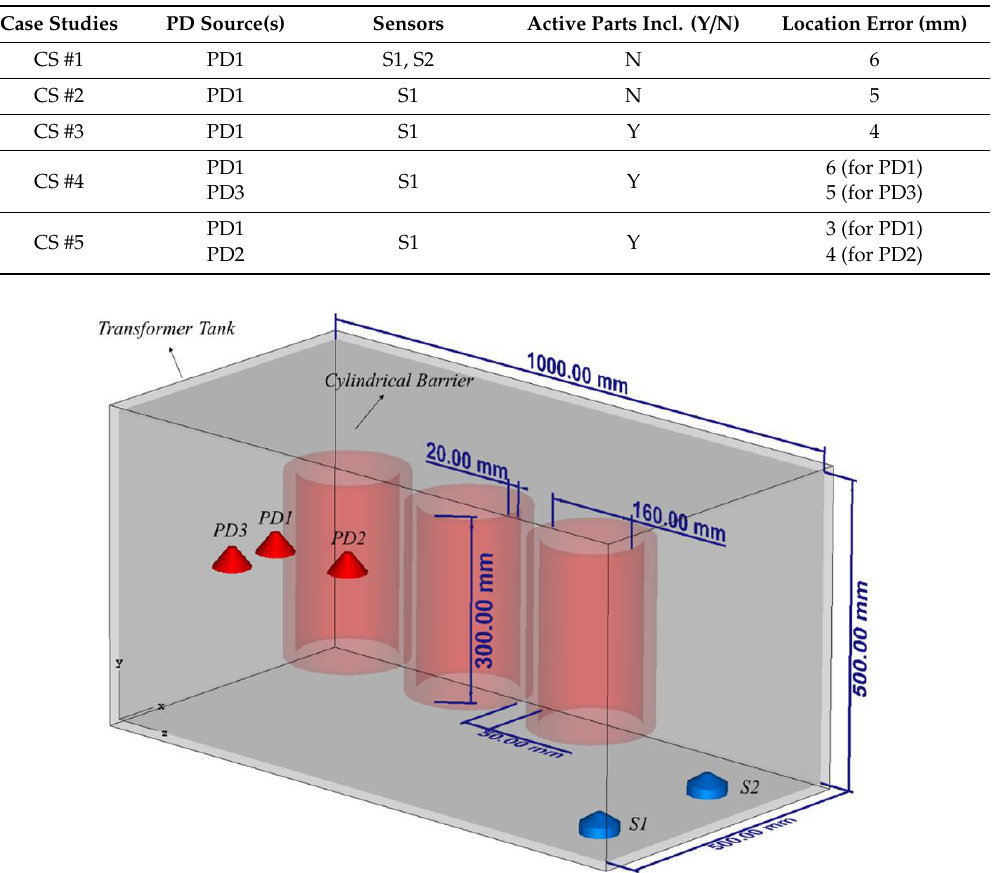
Figure 2. The geometry of the problem used in case studies CS #1-5 (see Table 1).